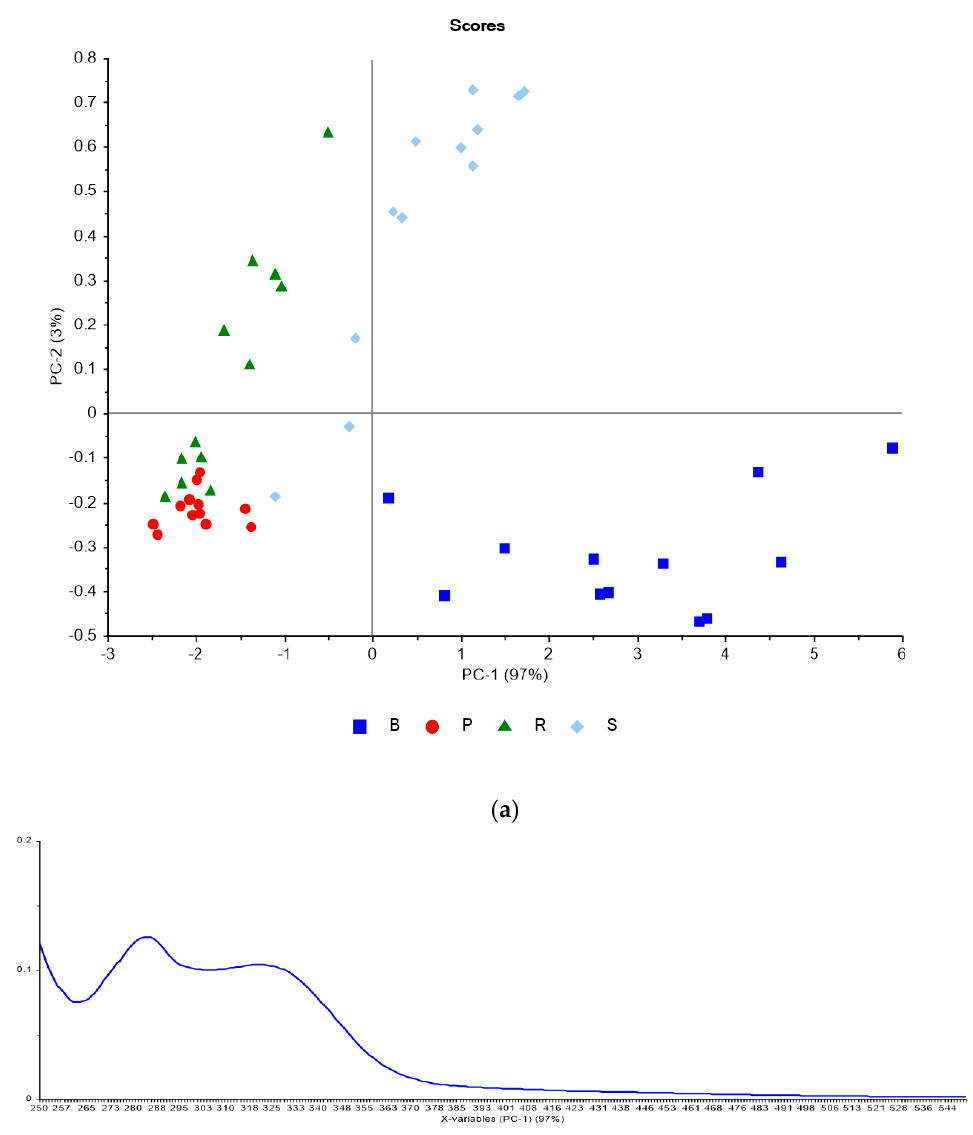
Figure 2. Spectral analysis of ‘Red Delicious’ (R), ‘Bulmer’s Norman’ (B), ‘Sturmer’ (S) and ‘Pink Lady’ (P) must. ( a ) Scores plot for principal component analysis (PCA), 250–550 nm. ( b ) Loadings plot for principal component 1 from PCA, 250–550 nm.